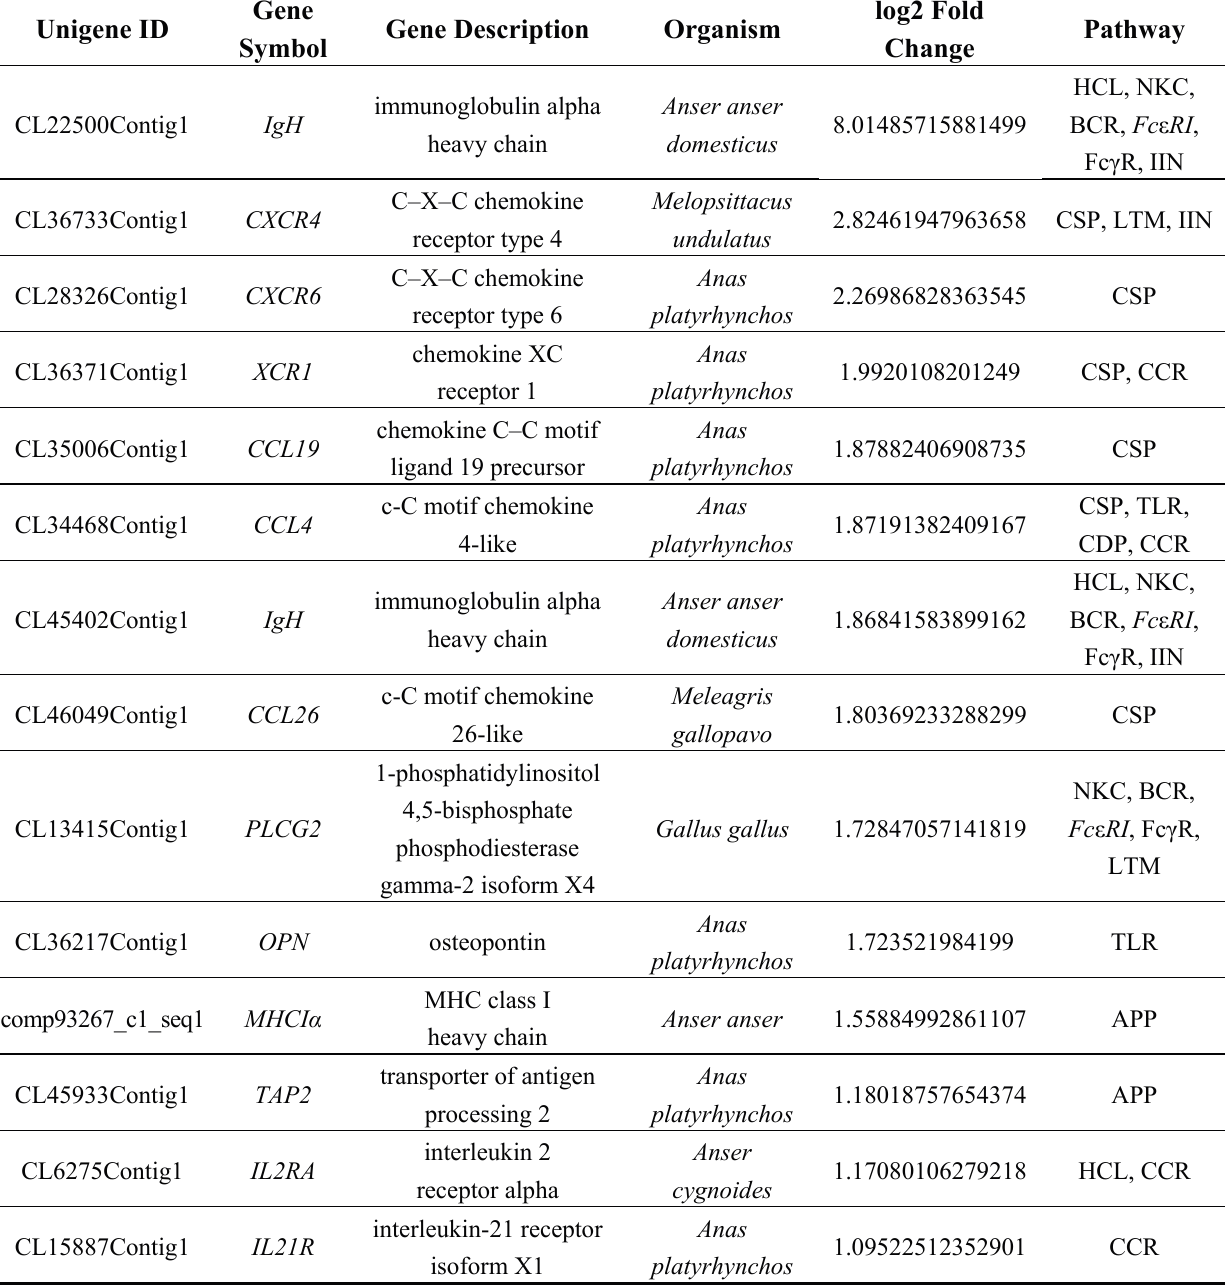
Table 4. Differential expression of genes involved in the immune